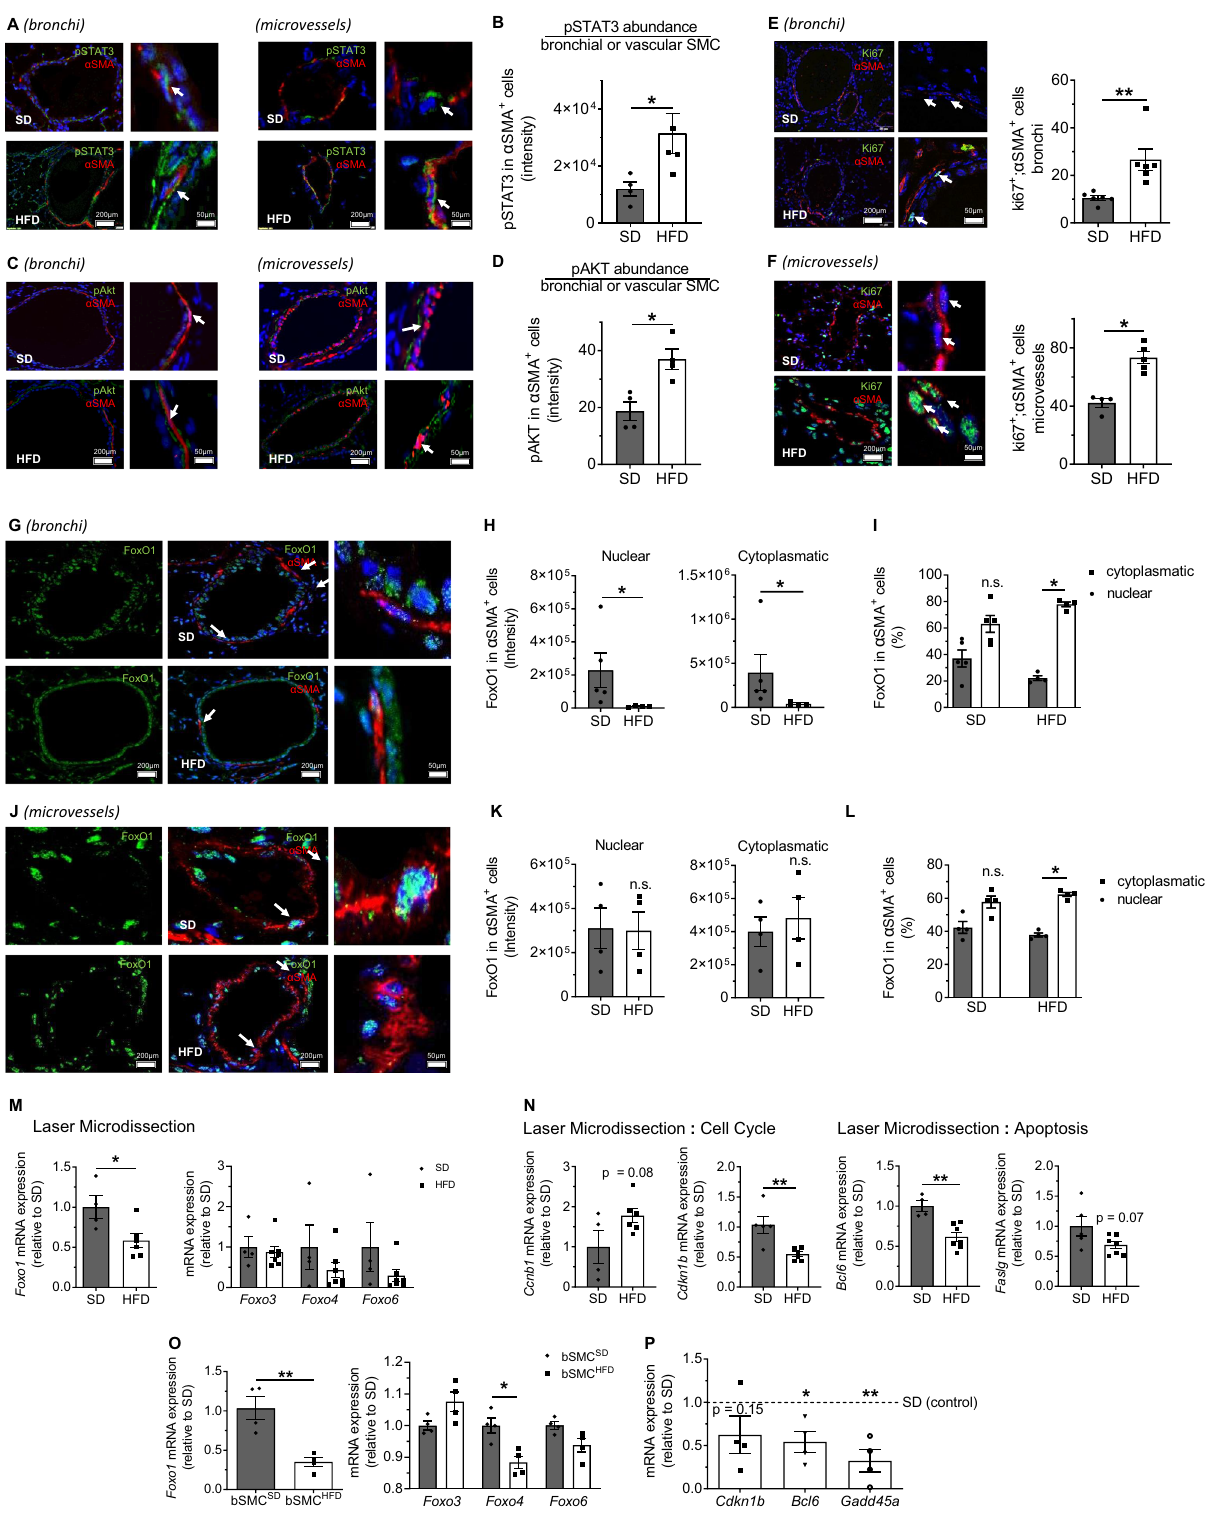
Laser Microdissection :